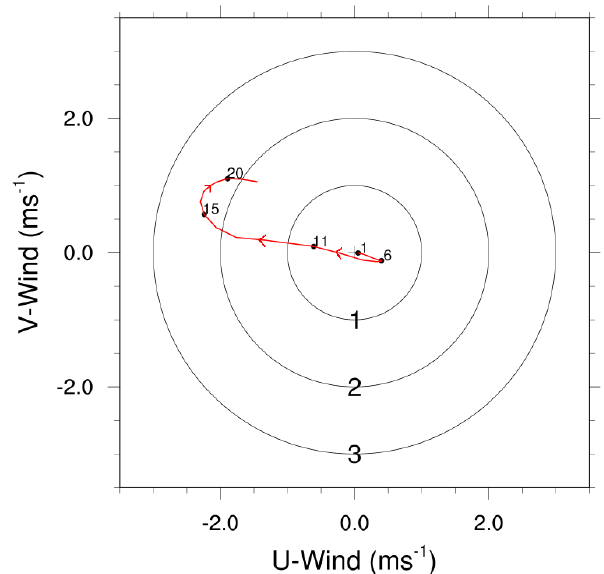
Fig. 8. Hodograph of the single coast baseline simulation at the coastline using the YSU PBL scheme and an SST of 287K. Num- bers labelled on the curve represent the simulation hour in UTC and concentric circles portray the magnitude of the 10m vector wind. The negative u-wind component represents onshore flow and the negative v-wind component represents shore parallel flow with the land mass to the